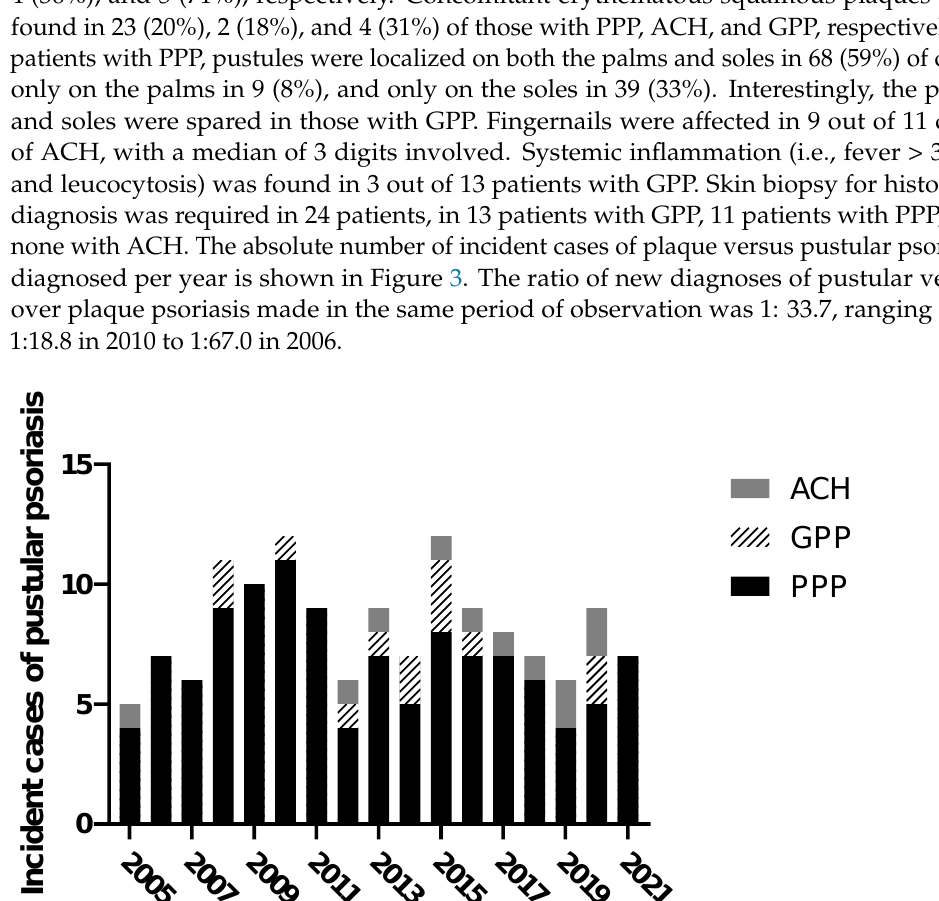
Table 1. The main characteristics of patients with pustular psoriasis ( n = 140).